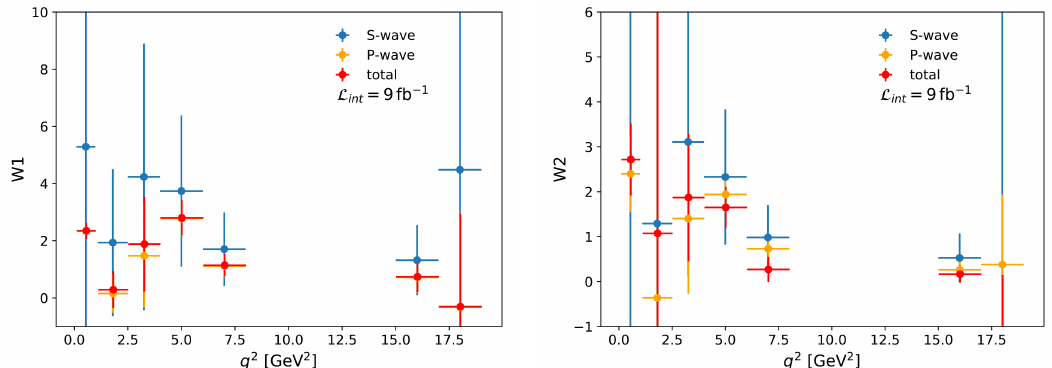
Figure 24 . Pseudo-experiment results for (left) W 1 and (right) W 2 with the LHCb Run 2 data set.